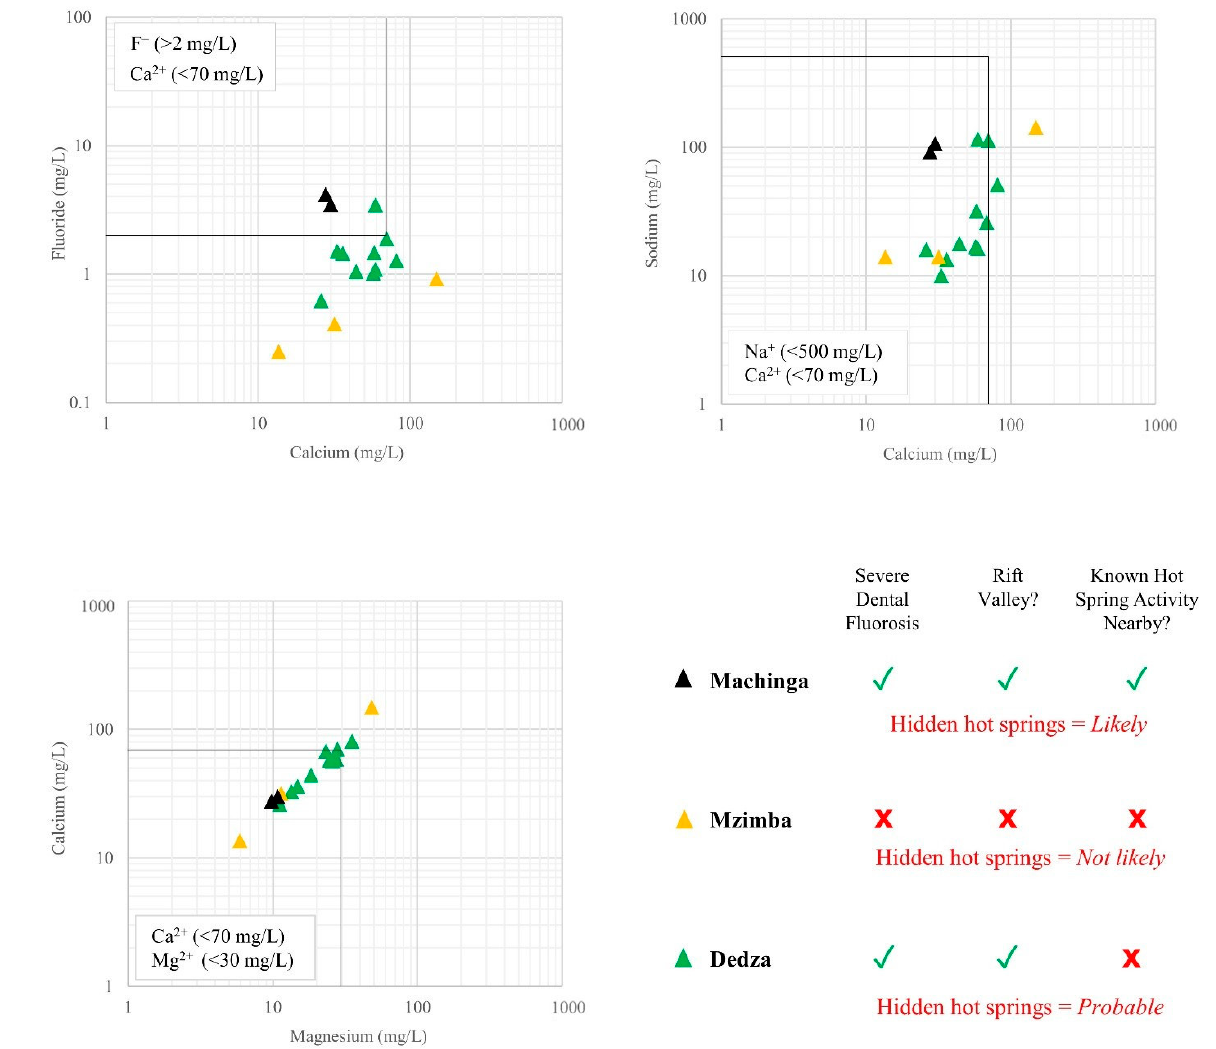
Figure 8. Geochemical data from school and village boreholes at Mzimba and Dedza, and those schools identified in Malawi literature as endemic fluorosis areas in Machinga District [10]. Black lines indicate geochemical proxy indicators for hot spring activity identified from the model data (Figure 4). lower right : Additional proxy indicators for hot spring activity (Table 1) for each area, with an overall prediction for hidden hot spring occurrence at each location.